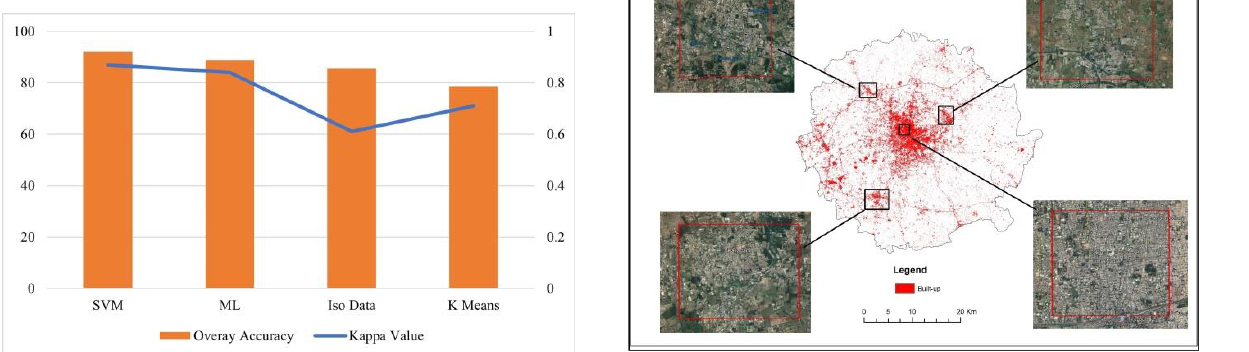
Figure 8. Google earth validation of Built